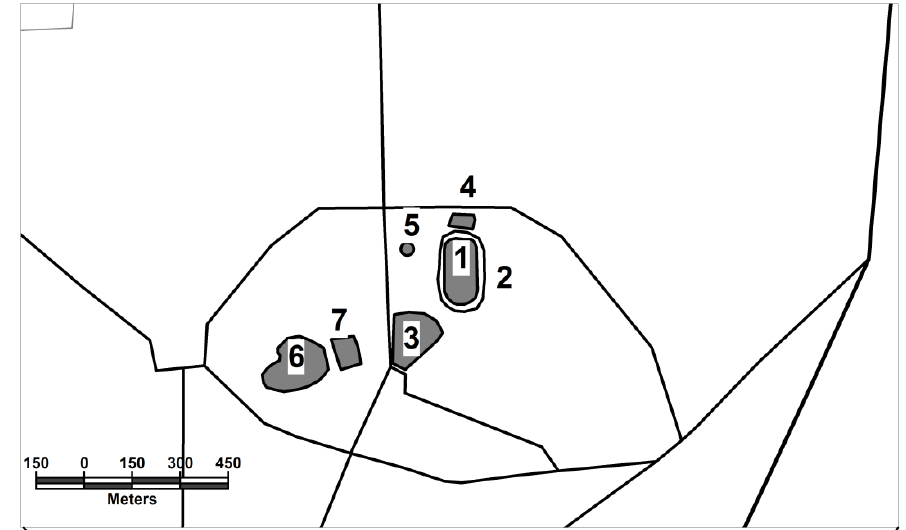
Figure 9. Most important elements of investments in Great Forest in 2010s. (The meaning of numbers is found in the text.) Source: own work.